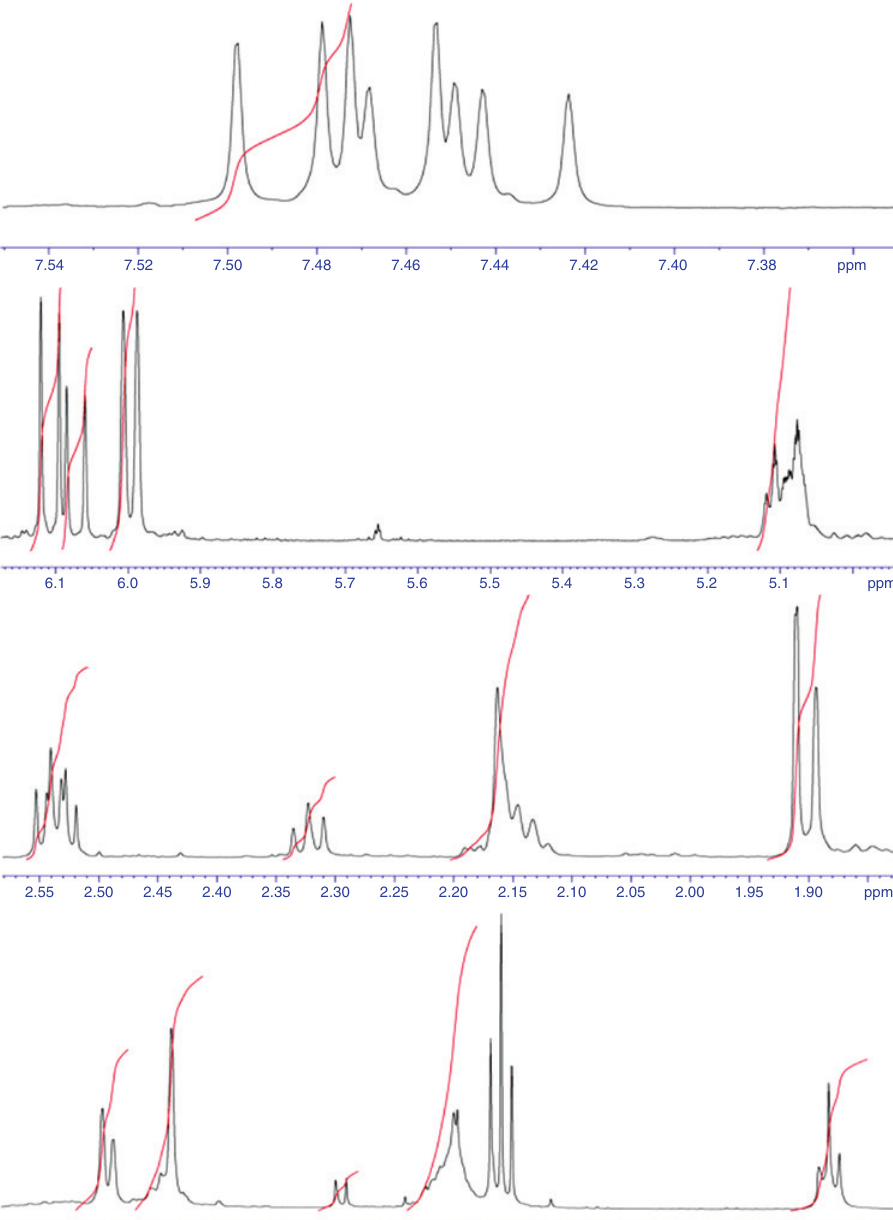
Figure 8: 1 H Nuclear magnetic resonance (NMR) spectrum of 11,15-dimethyl-hexadeca-8,10,14-trien-7-one isomers.